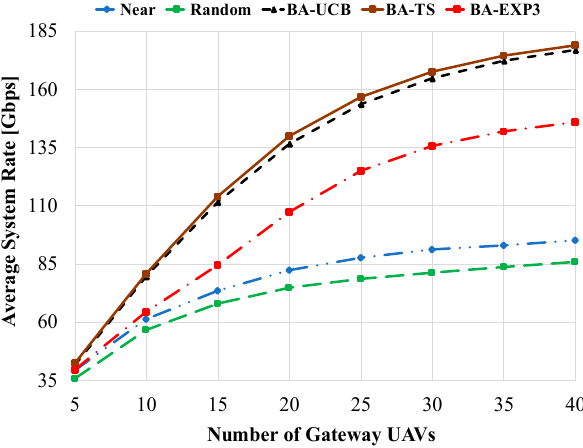
Figure 4. Average system rate against the number of access UAVs using gateway UAVs of 20 and a beam-width of 60°.